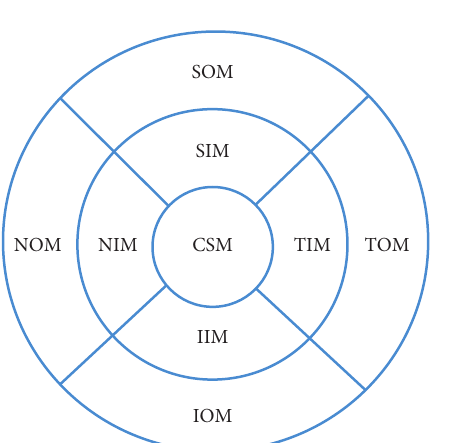
Figure 1: Measurement illustration of macular choroidal thickness at nine locations: CSM, central subfield macula; NIM, nasal inner macula; SIM, superior inner macula; IIM, inferior inner macula; TIM, temporal inner macula; NOM, nasal outer macula; SOM, superior outer macula; IOM, inferior outer macula; TOM, temporal outer